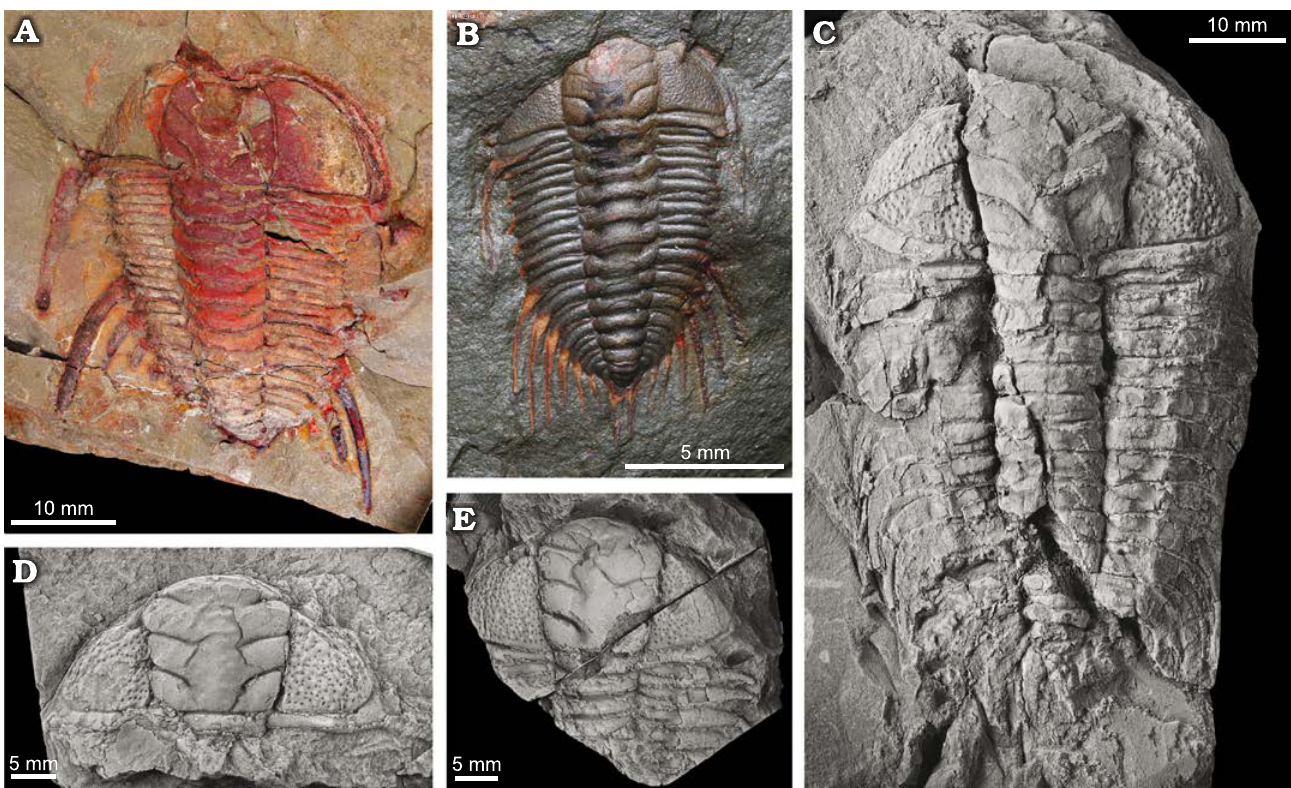
Fig. 2. Cheirurid trilobites Anacheirurus adserai (Vela and Corbacho, 2007) from the Fezouata Shale, Araneograptus murrayi Zone, Tremadocian, Lower Ordovician, near Beni Zouli, Zagora Province, Morocco (A, B) and Lehua vinculum (Barrande, 1852) from the Dobrotivá Formation, upper Darriwilian to lowermost Sandbian, Zaječov-Svatá Dobrotivá, Czech Republic (C–E). A . YPM 522182, part, complete holaspid with hypostome impressed. B . YPM 530933, complete holaspid. C . NM L19066, complete holaspid. D . NM L19075, complete cranidium . E . JV1607, anterior half of an holaspid specimen. Specimens in C–E covered by ammonium